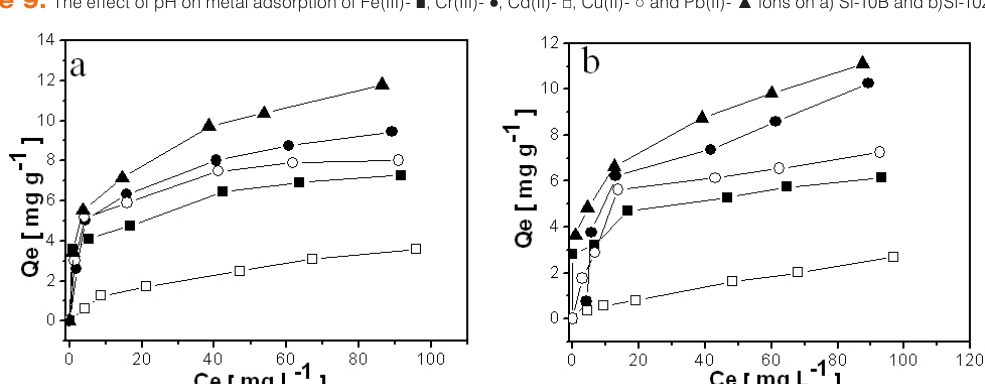
Figure 9. The effect of pH on metal adsorption of Fe(III)- ■ , Cr(III)- ● , Cd(II)- □ , Cu(II)- ○ and Pb(II)- ▲ ions on a) Si-10B and b)Si-10Zr.